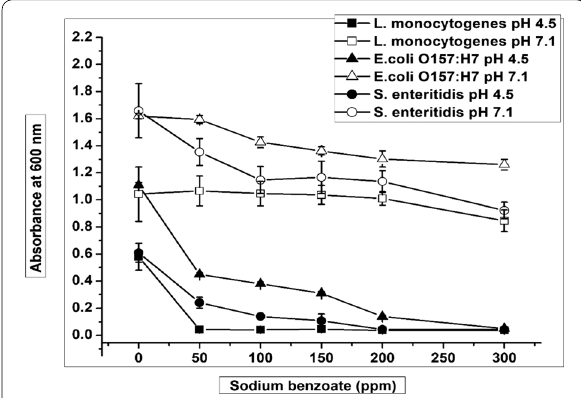
Fig. 5 Influence of different pH values on bactericidal activity of sodium benzoate against E. coli O157:H7 , S. enteritidis, and L. monocytogenes. Sodium benzoate concentrations (0, 5, 10, 15, 20, and 25) ppm were each added to 10-ml tryptone soya broth tubes and then inoculated (50 μl) of an overnight culture of bacterial suspension (O.D 600 1.818). Tubes were incubated at 37 °C for 24 h. Negative = and positive controls were performed. The optical density of each tube was measured using a spectrophotometer. Data shown as a mean of two independent experiments with standard error ( P < 0.05)